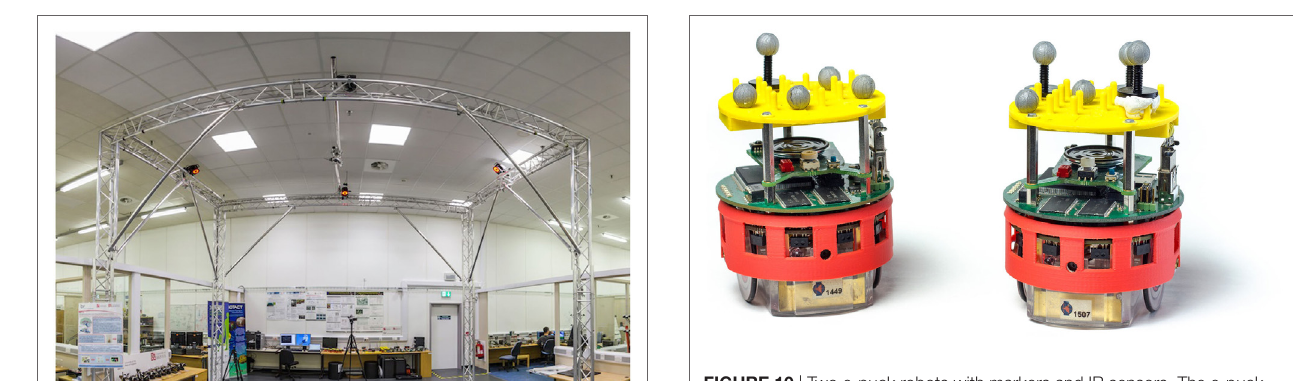
FigUre 10 | Two e-puck robots with markers and IR sensors. The e-puck with Linux board fitted in between the e-puck motherboard (lower) and the e-puck speaker board (upper). Note the yellow “hat,” which provides a matrix of pins for the reflective marker spheres, which allow the tracking system to identify and track each